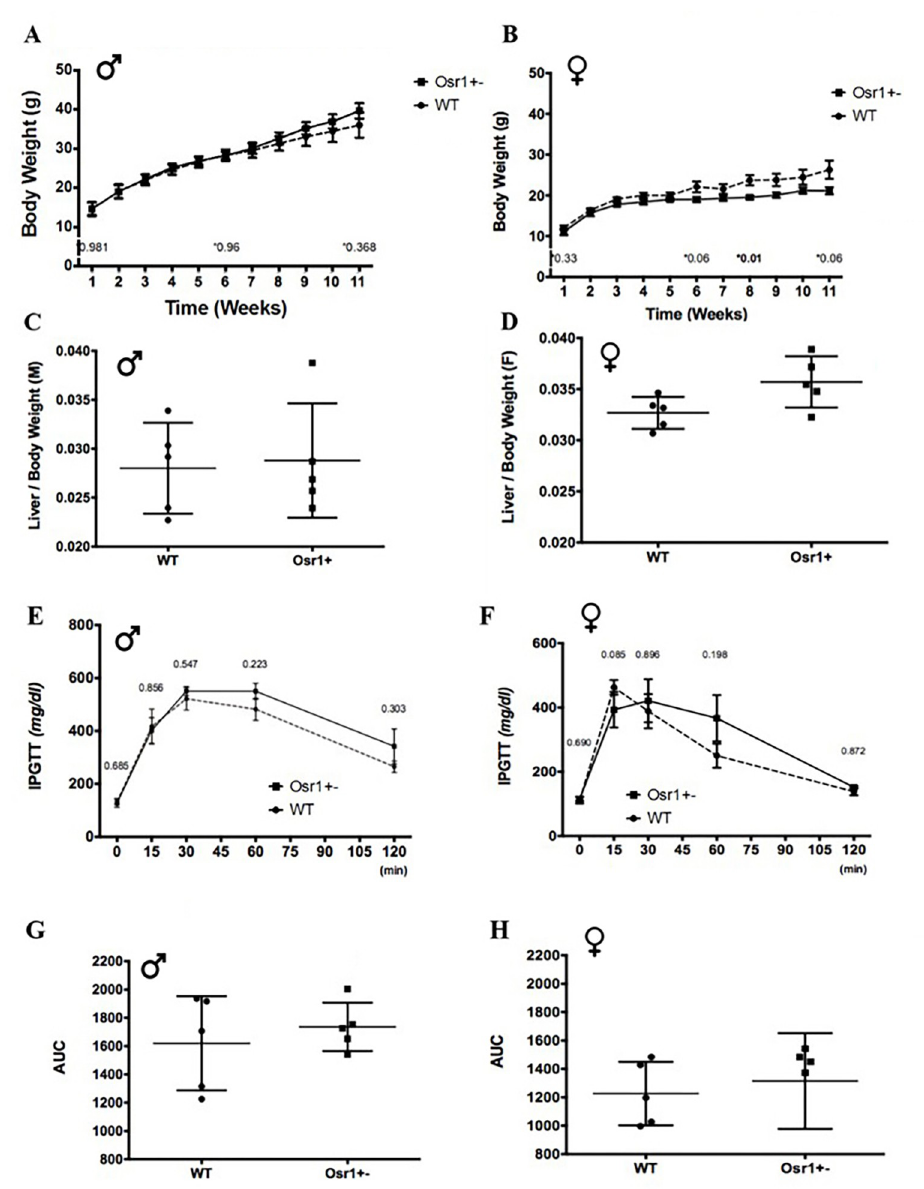
Fig 1. Body weight and glucose tolerance during the experimental period. (A). Male mice body weight growth log from weaning to week 10 indicated no significant difference between groups. (B). Female Osr1 mice started to gain more body weight at week 6. (C). Male mice organ to body weight ratio exhibited no significant difference between groups. (D). Osr1 heterozygous female mice showed larger liver weights. (E). At week 10, no significant differences were noted in glucose tolerance between male mice groups. (F). Male mice IPGTT area under curve. (G). Week 10 IPGTT indicated no significant difference between female mice groups. (H). Female mice IPGTT area under curve. AUC: Area Under Curve. Data is presented as Mean ± SD, N = 5–7; � p < 0.05. steatosis. WT male mice displayed little or mild microvesicular steatosis, with most lipid depo- sition observed as minor intracytoplasmic vacuoles. Osr1 mice however showed mild to severe hepatosteatosis, with clustered and ballooning perivenular lipid macrovesicles (Fig 2A). When comparing the total area of steatosis between male mouse groups, Osr1 heterozygous mice